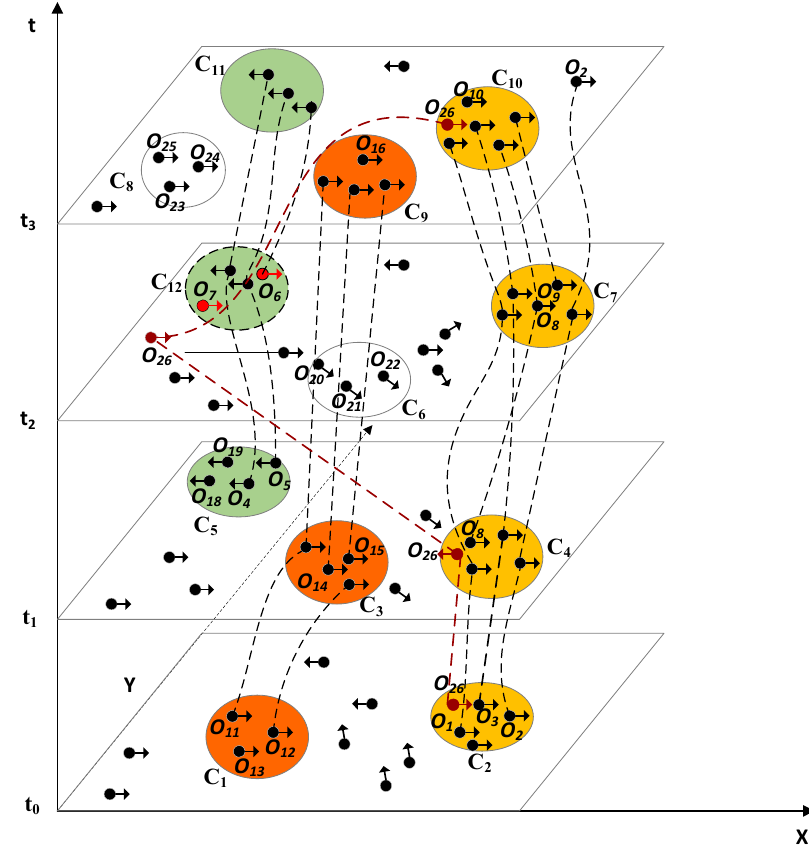
Figure 1. Example of loosely moving congestion